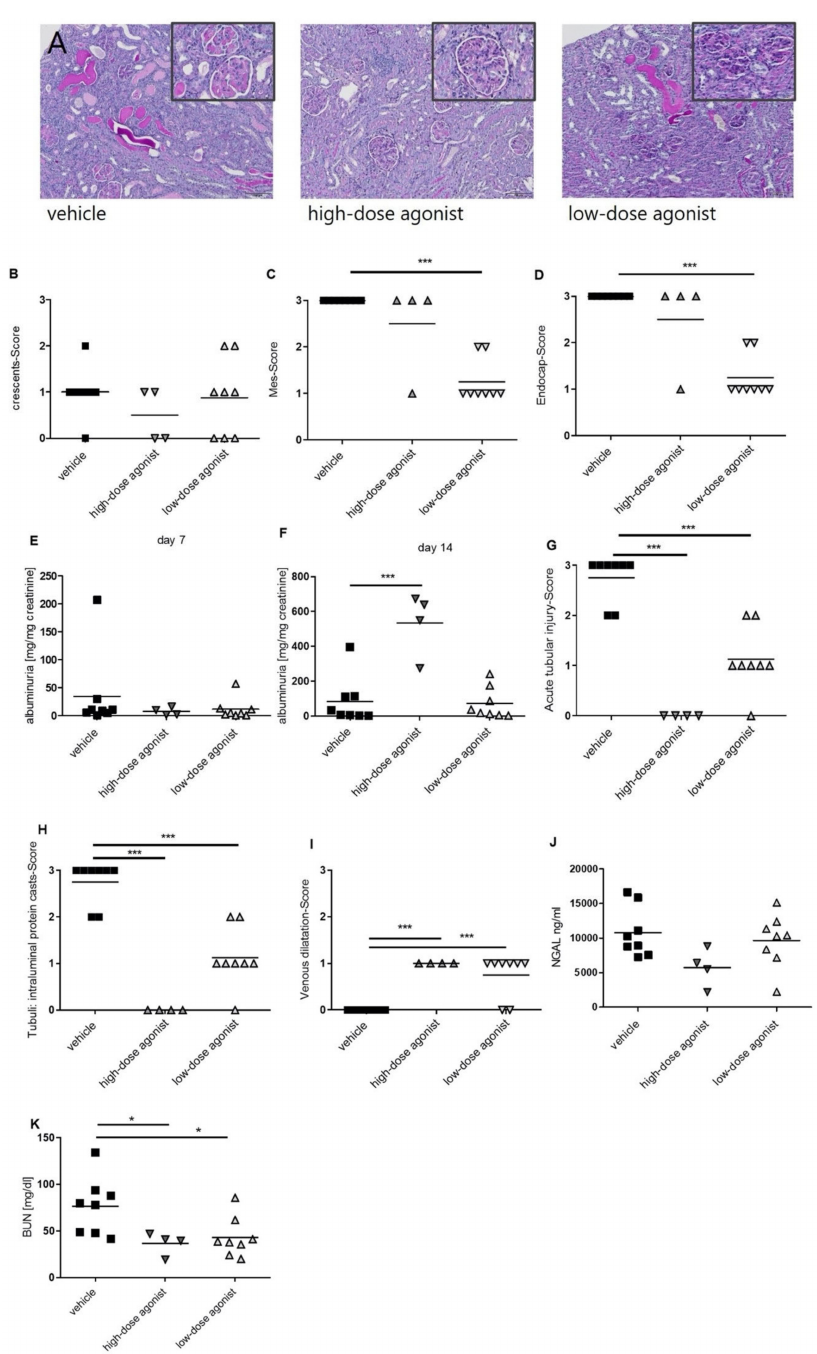
Figure 1. EP4 receptor agonism improved the phenotype of nephrotoxic serum nephritis (NTS). Fourteen days after NTS induction, kidneys of mice treated with vehicle, high-dose EP4 receptor agonist, or low-dose EP4 receptor agonist were harvested, and PAS-staining was performed ( A ). Representative pictures are shown. Stained kidney sections were quantified for glomerular and kidney damage ( B – D ). Urine samples collected on day 7 ( E ) and 14 ( F ) were analyzed for albumin and creatinine. In order to quantify for tubular damage acute tubular injury score ( G ) and tubular cast formation, six high-power fields (HPF) ( H ) were evaluated. Venous dilatation score ( I ) was quantified. Serum neutrophil gelatinase-associated lipocalin (NGAL) levels ( J ) and serum blood urea nitrogen (BUN) levels ( K ) were evaluated on day 14. (* p ≤ 0.05, *** p ≤